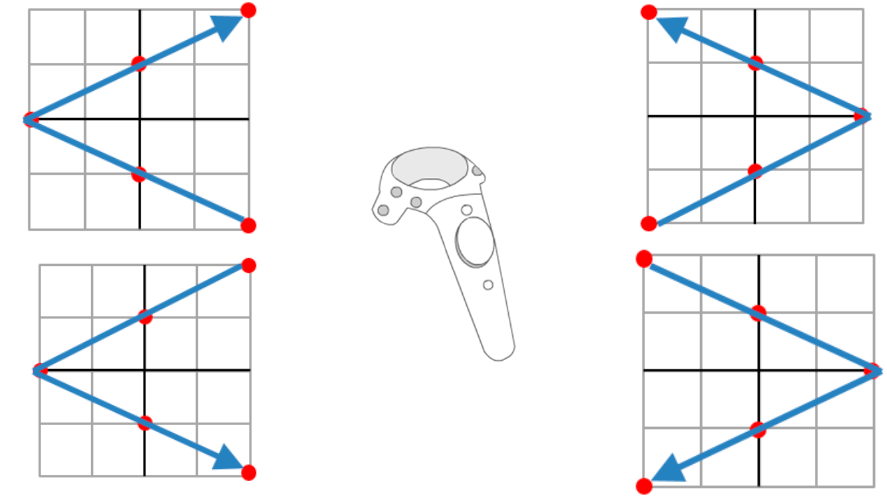
Figure 10. Four recognition targets for horizontal V-shaped recognition targets. Table 2. Details of four recognition targets for vertical V-shapes.